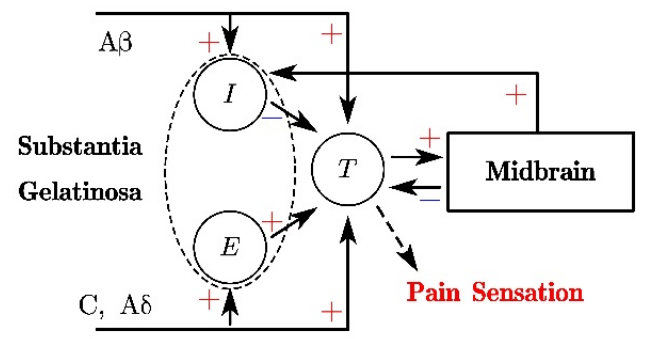
Figure 4. The schematic of the mathematical model of gate control theory (GCT).